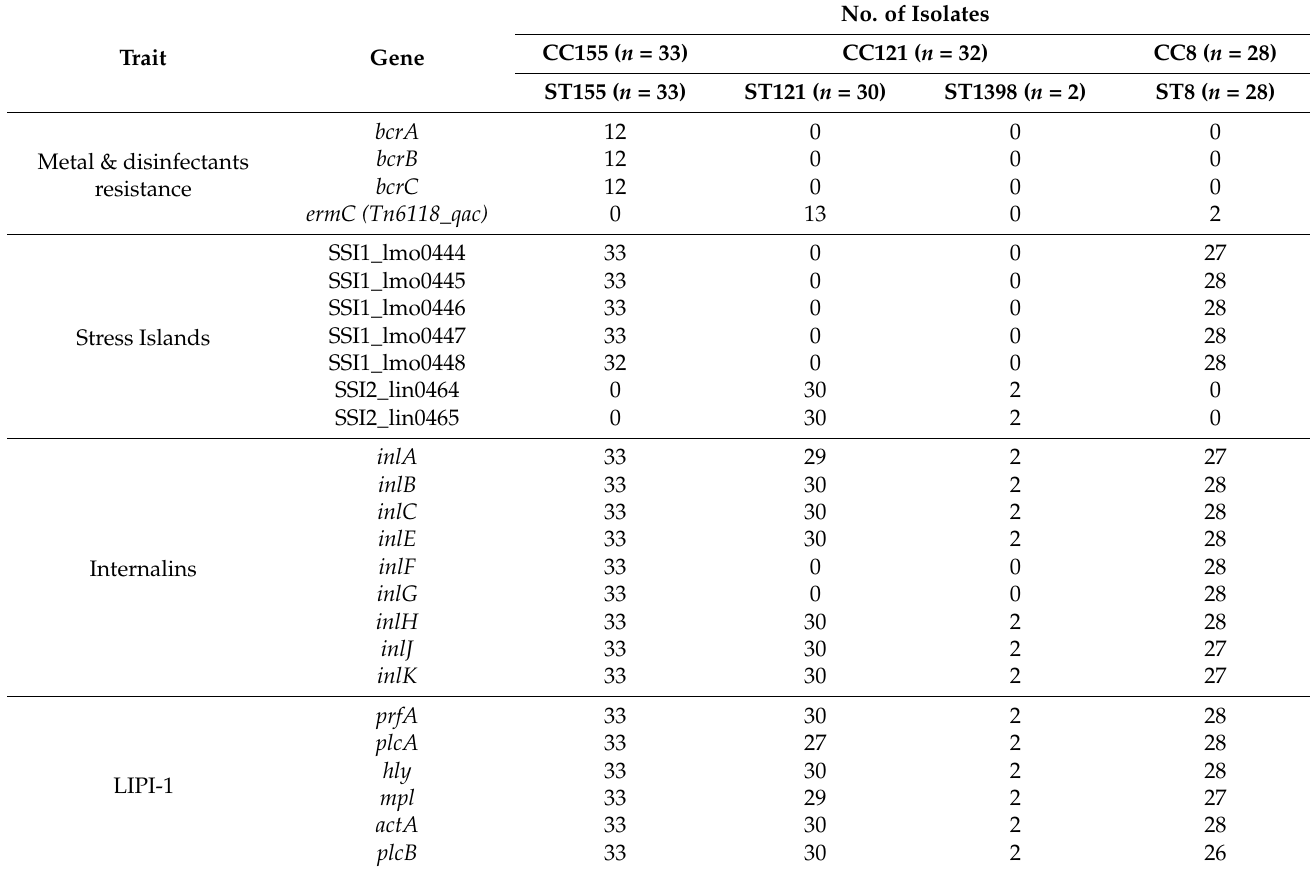
Table 2. Distribution of virulence and resistance factor genes among L. monocytogenes isolates tested in relation to the clonal complexes (CCs) and sequence types